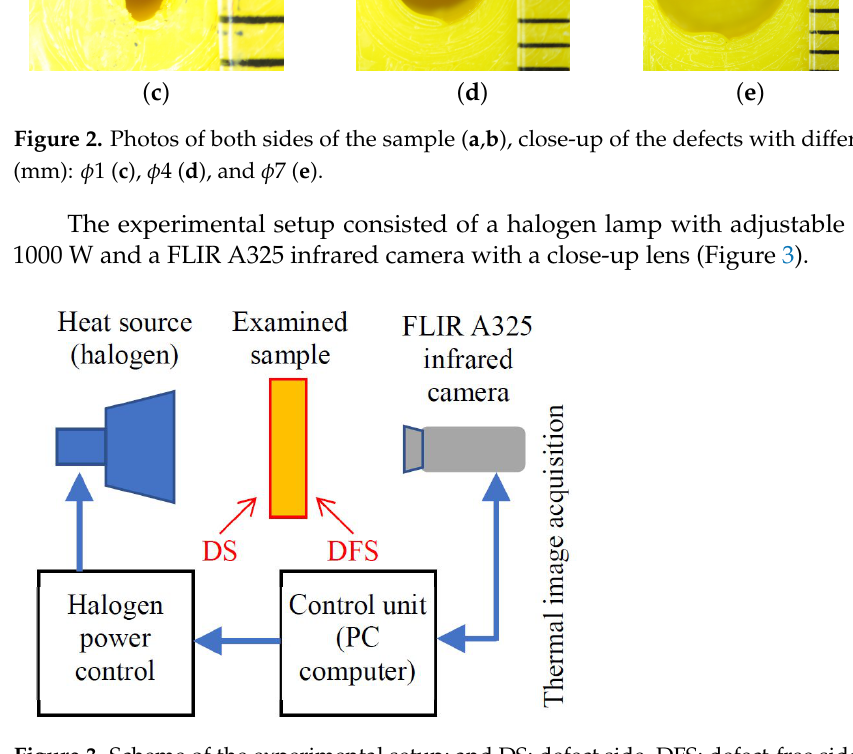
Figure 3. Scheme of the experimental setup; and DS: defect side, DFS: defect-free